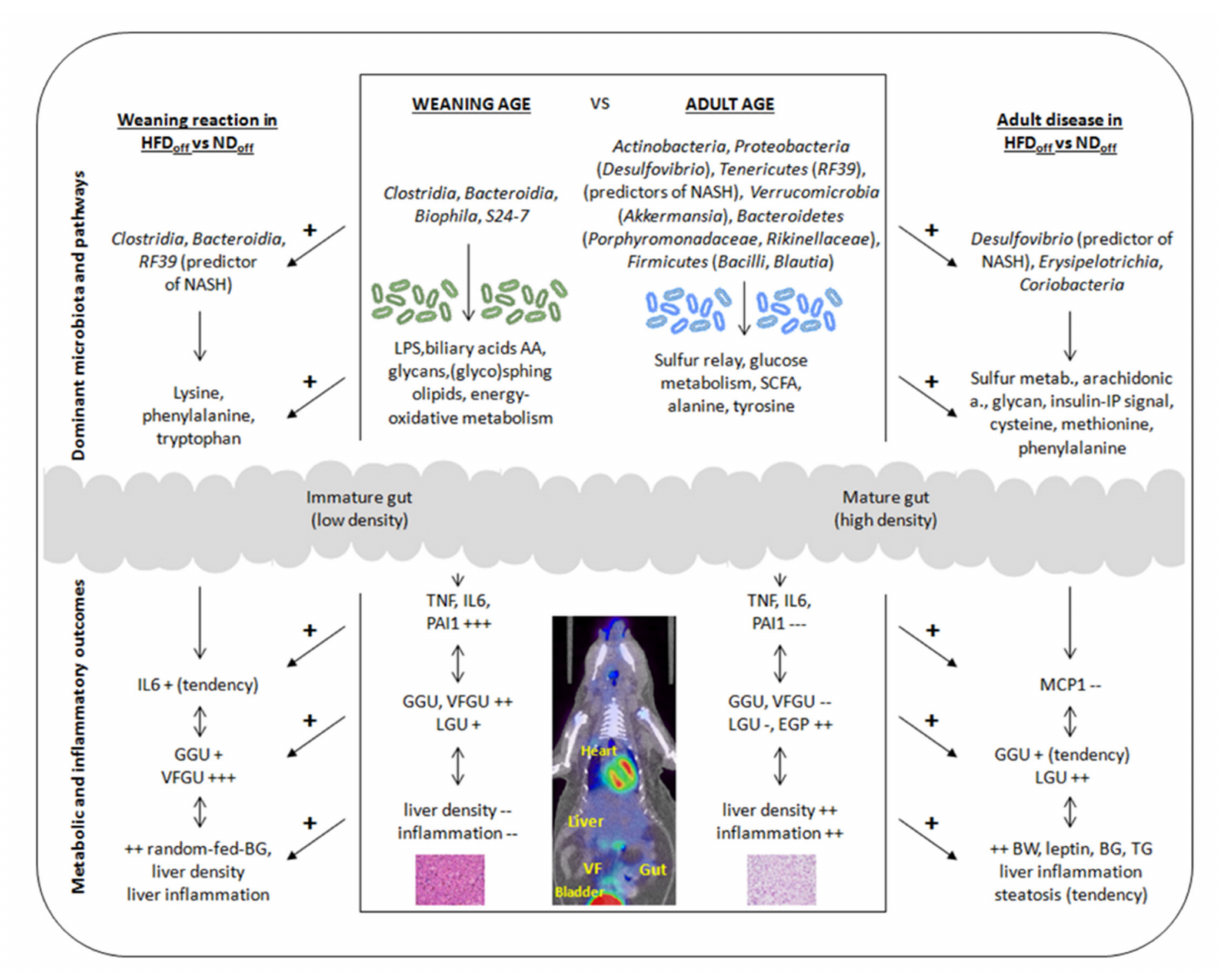
Figure 4. Exemplified diagram summarizing the findings of the study, illustrating changes in microbiota, and systemic and tissue outcomes according to the hypothesized sequence of events, from weaning to adulthood (mid-panel), or accounting for maternal diet at weaning (left panel) or adult age (right panel). GGU, VFGU, LGU = glucose uptake in gut, visceral fat, liver, respectively, BG = blood glucose, and TG = triglyceride levels, EGP = endogenous glucose production, NASH = non-alcoholic steatohepatitis, LPS = lipopolysaccharide, AA = amino acids, SCFA = short-chain fatty